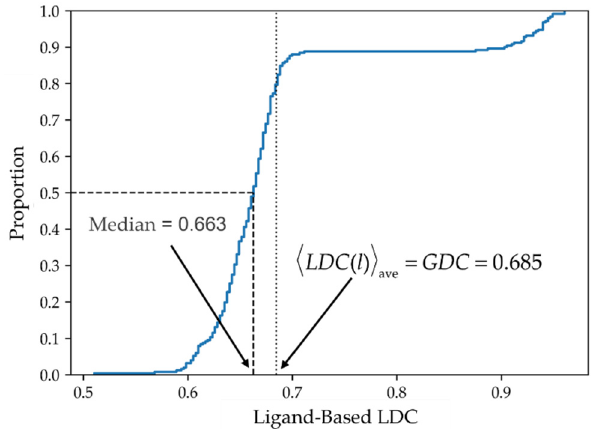
Figure 6. Cumulative distribution of ligand-based local data completeness, LDC ( l ) . The cumulative distribution of the ligand data completeness for all 250 ligands is shown in blue.